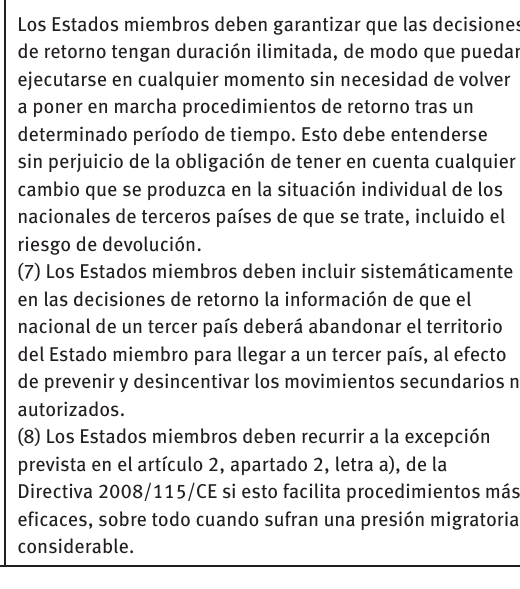
Increasingly, return and reintegration programming is